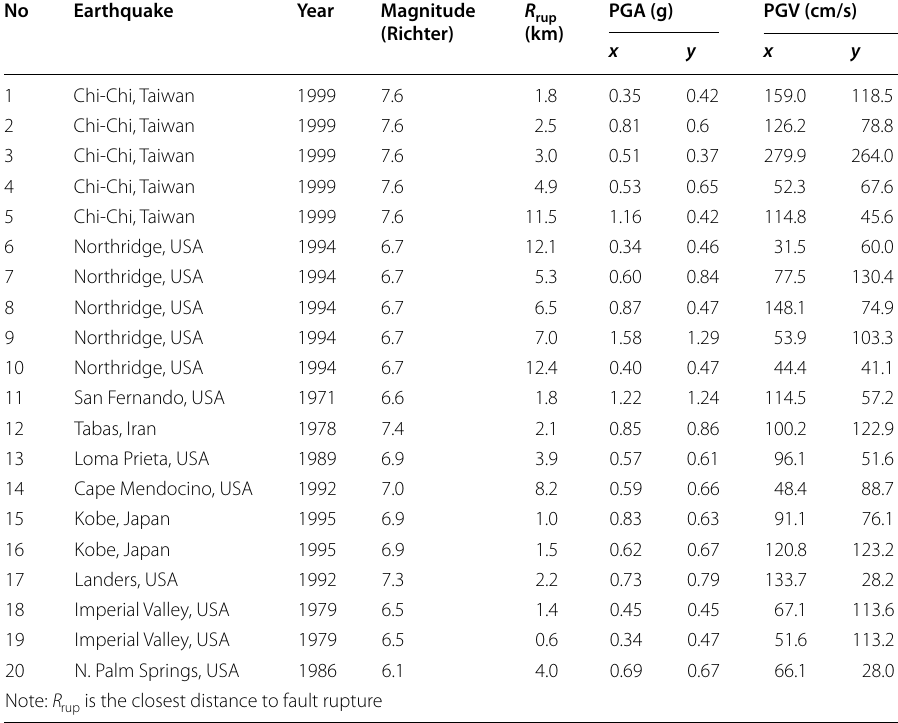
Table 2 Basic properties of the near-fault ground motions No